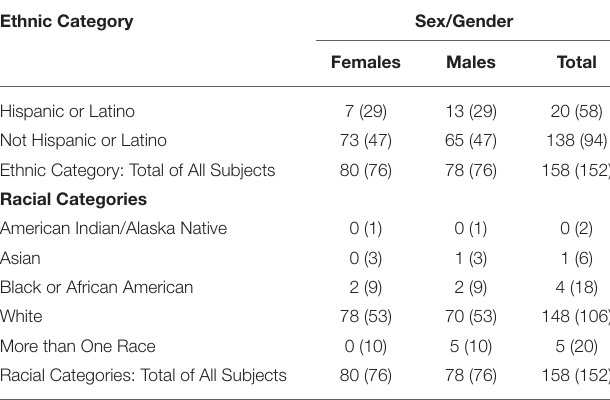
significant levels of depression (15 or more on the PHQ-9). The TABLE 3 | The ethnic and racial characteristics of the